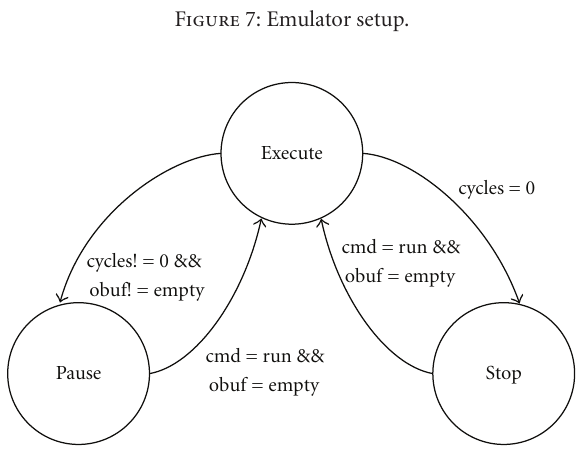
Figure 8: Hardware adaptor state machine.